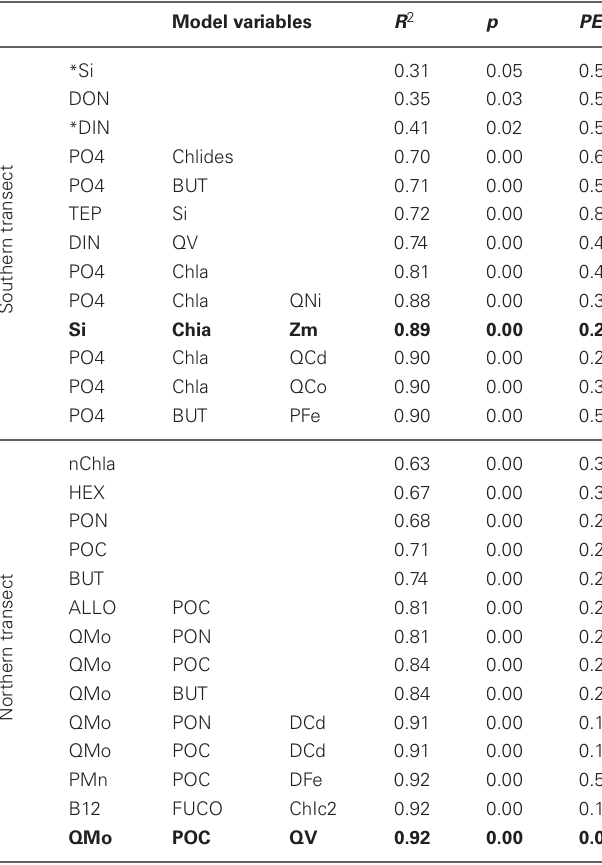
Table 4 | Linear models and diagnostic statistics for DMS, only statistically significant regressions for up to three variables are